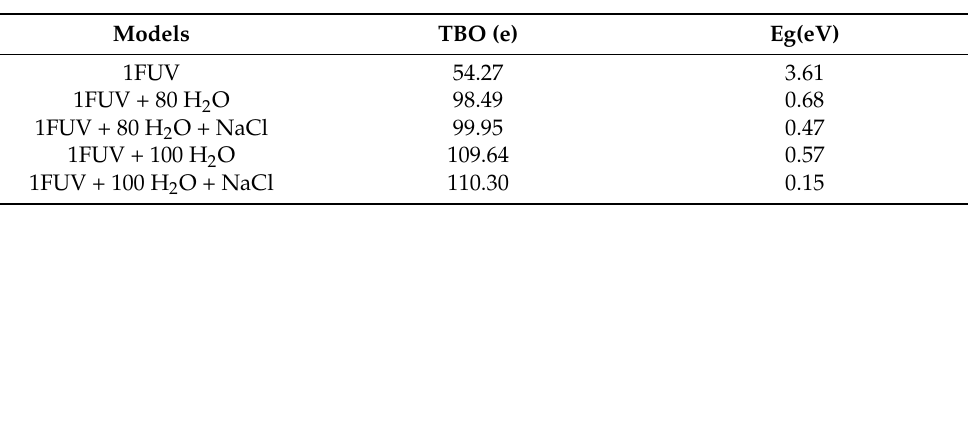
Table 1. Total bond order (TBO) and band gap (Eg) for five 1FUV